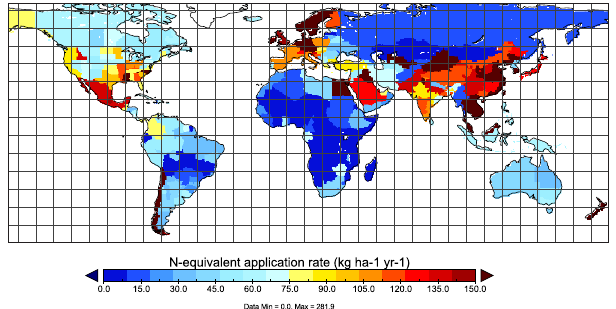
Figure 3. N-equivalent application rate of nitrogen fertilizers for the production of